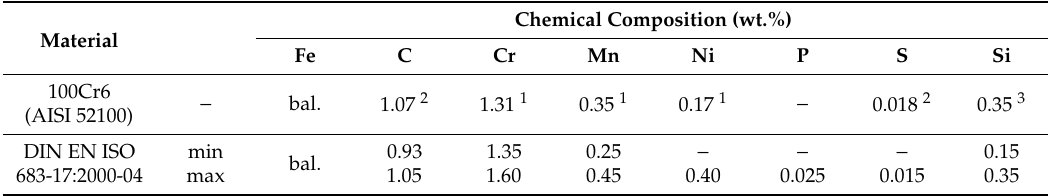
Table 1. Chemical composition of the investigated microspheres in comparison with the limitations of the DIN EN ISO 683-17:2000-04